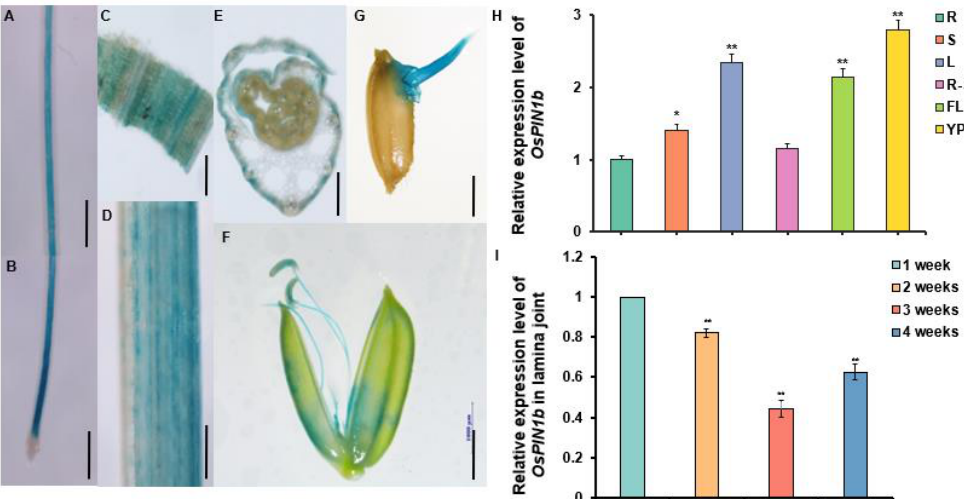
Figure 3. Expression pattern of OsPIN1b gene. GUS staining in each tissue of ProOsPIN1b: GUS transgenic rice. Ten biological replicas were analyzed for each tissue. Scale bars = 1 mm. ( A ) Maturation region of primary root, ( B ) elongation zone, meristem zone, and root cap of primary root, ( C ) stem, ( D ) leaf, ( E ) transverse section of leaf sheath, ( F ) floral organ, ( G ) the germinated seed for 3 days. ( H ) qRT-PCR analysis of relative expression level of OsPIN1b in different tissues of WT/NIP. R: root; S: stem; L: leaf; R-S: root-stem junction; FL: flag leaf; YP: Young panicle. OsACTIN was used as an internal control. The data are mean ± SD (n = 3) and asterisks indicate significant differences in different tissues (* p < 0.05, ** p < 0.01; Student’s t -test). ( I ) qRT-PCR analysis of relative expression level of OsPIN1b in lamina joint at different stages of WT/NIP from one to four weeks. The three independent biological repeats were performed in the qRT-PCR analysis. OsACTIN was used as an internal control. The data are mean ± SD (n = 3) and asterisks indicate the significant differences in different stages (** p < 0.01; Student’s t -test).